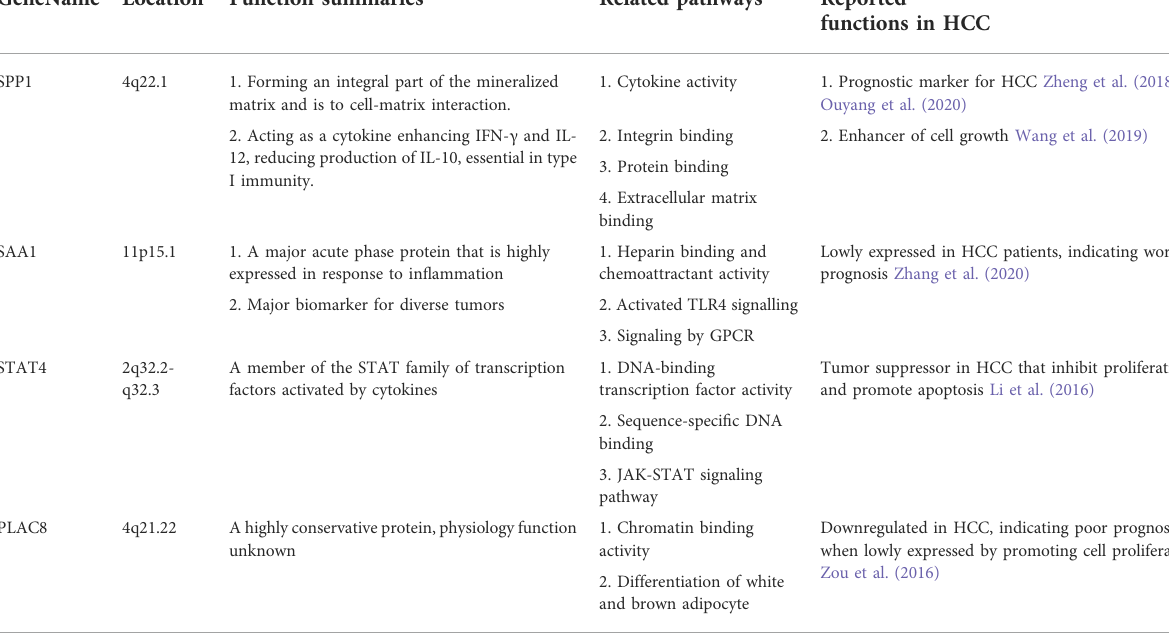
TABLE 4 Summary for markers related to the malignant phenotype or clinical prognosis of HCC. GeneName Location